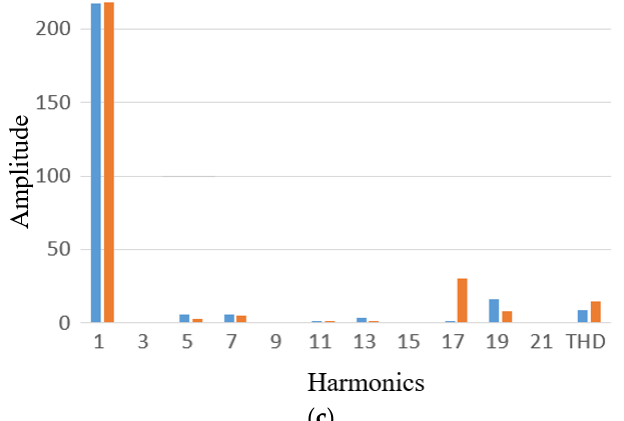
Figure 1. Changes in rotor geometry and their corresponding performance. ( a ) Enlarging the arc side; ( b ) Cutting the teeth side; ( c ) Fast Fourier transformation (FFT) analysis of induced electromagnetic motive force (EMF).